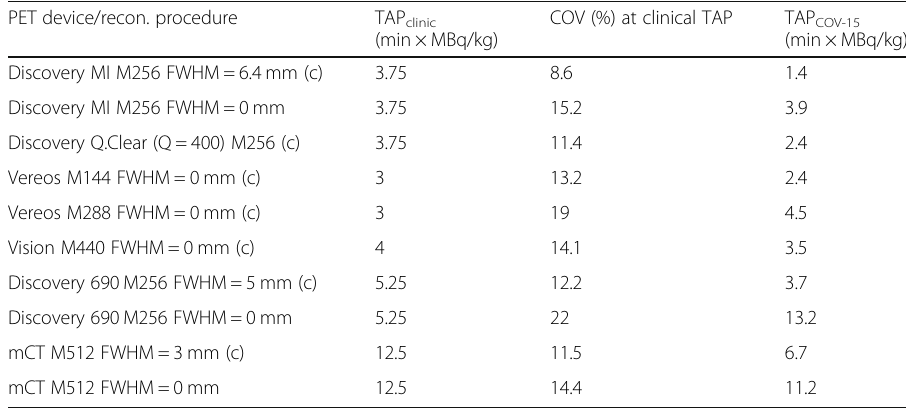
COV-15 ). Reconstruction